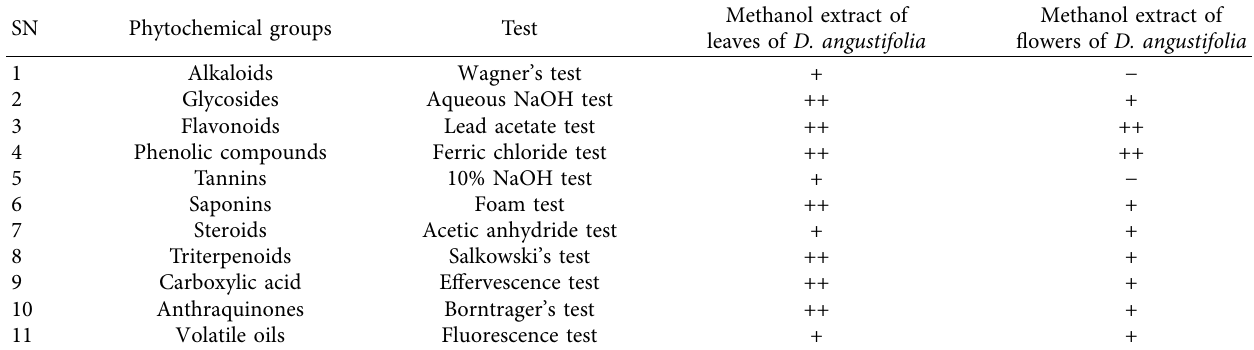
Table 2: Test result for qualitative phytochemical screening for leaves and fowers.